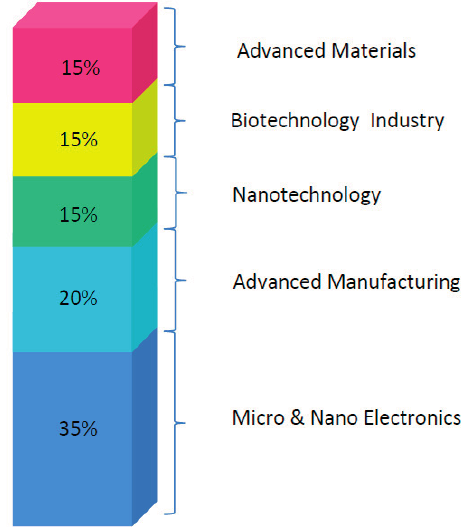
Figure 2. Suggested distribution of Key Enable Technologies (KETs) in a general implantable monitoring